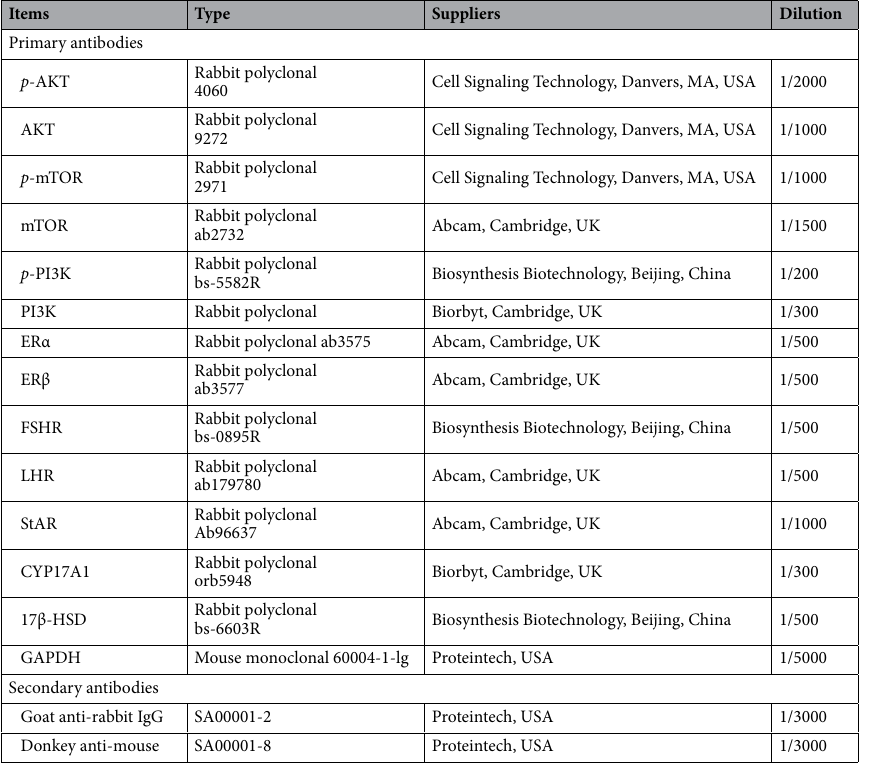
Table 2. Antibodies, suppliers and dilutions used for western blot